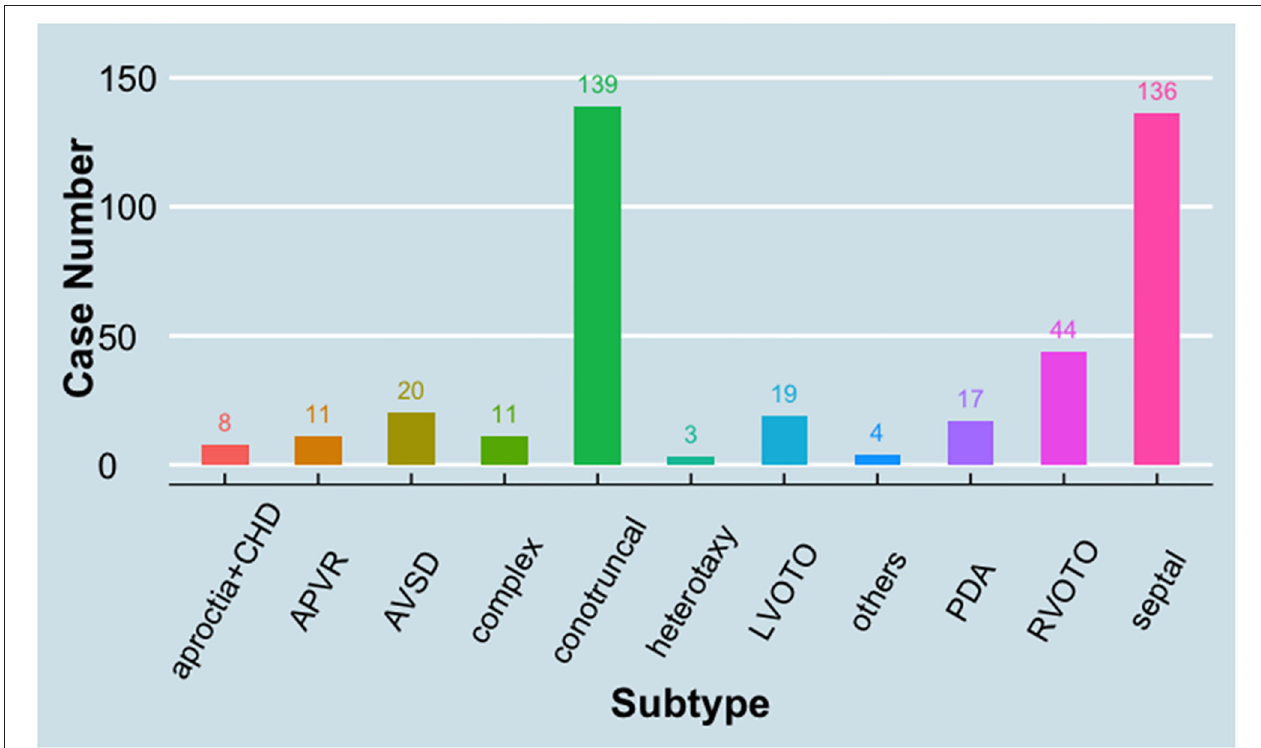
FIGURE 1 | Distribution of case subtypes in the study. APVR, anomalous pulmonary venous return; AVSD, atrioventricular septal defect; CHD, congenital heart defect; LVOTO, left ventricular outflow tract obstruction; PDA, patent ductus arteriosus; RVOTO, right ventricular outflow tract obstruction.